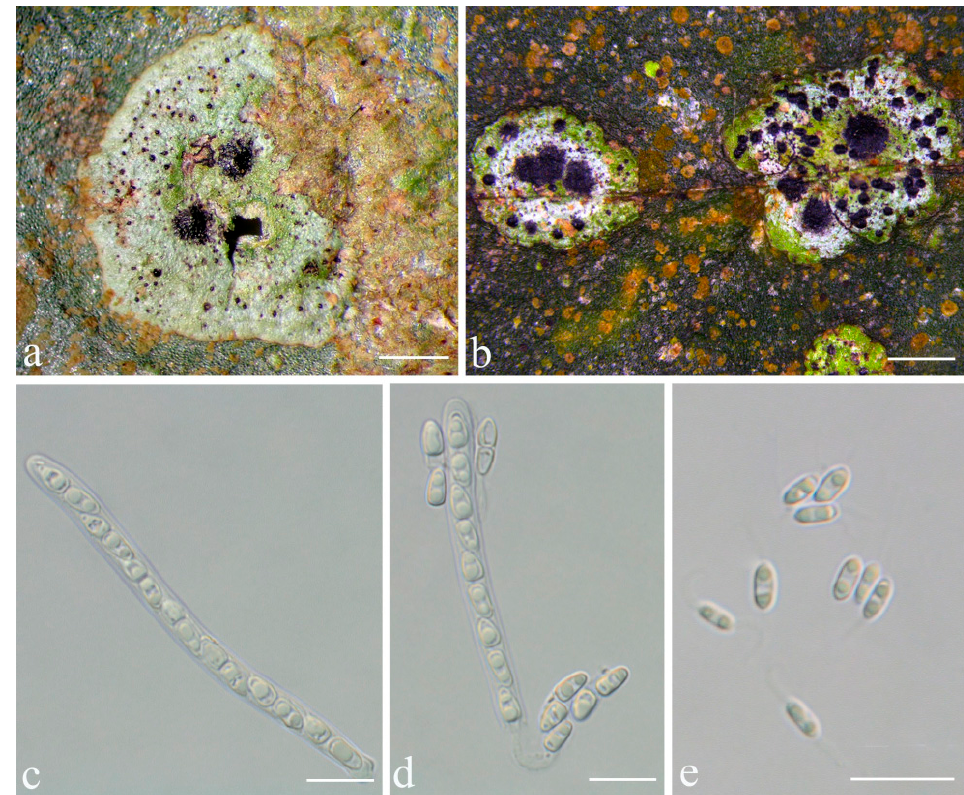
Figure 14. Strigula sinoconcreta sp. nov. (holotype, HMAS–L0139630). ( a , b ) Thallus; ( c , d ) asci and ascospores; ( e ) macroconidia. Scale bars: ( a ) = 300 μ m, ( b ) = 500 μ m, ( c – e ) = 10 μ